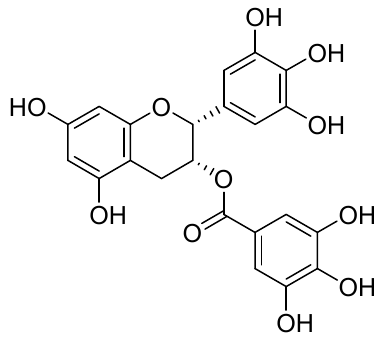
Figure 1. Chemical structure of ( − )-epigallocatechin gallate (EGCG).